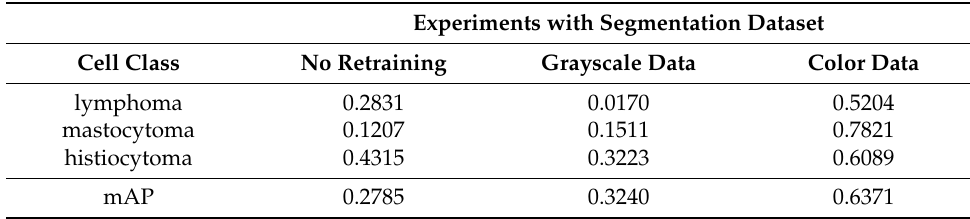
Table 6. Average Precision results for different experiments with segmentation